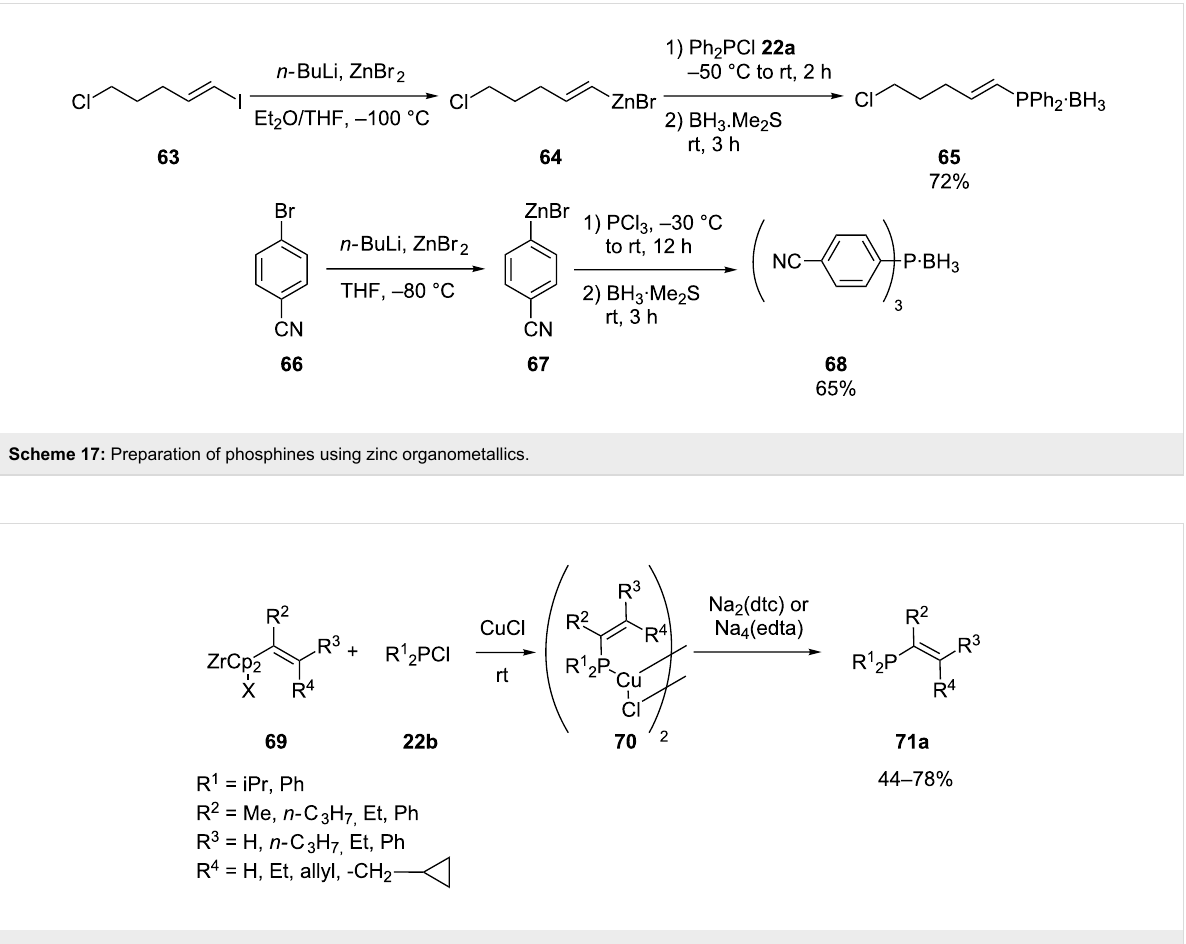
Scheme 18: Preparation of alkenylphosphines 71a from alkenylzirconocenes 69 (dtc = N,N -diethyldithiocarbamate, edta = ethylenediaminetetra-